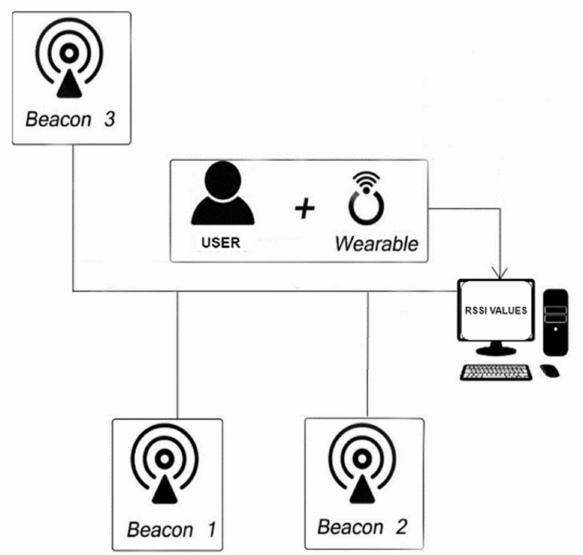
Figure 1. The proposed approach.